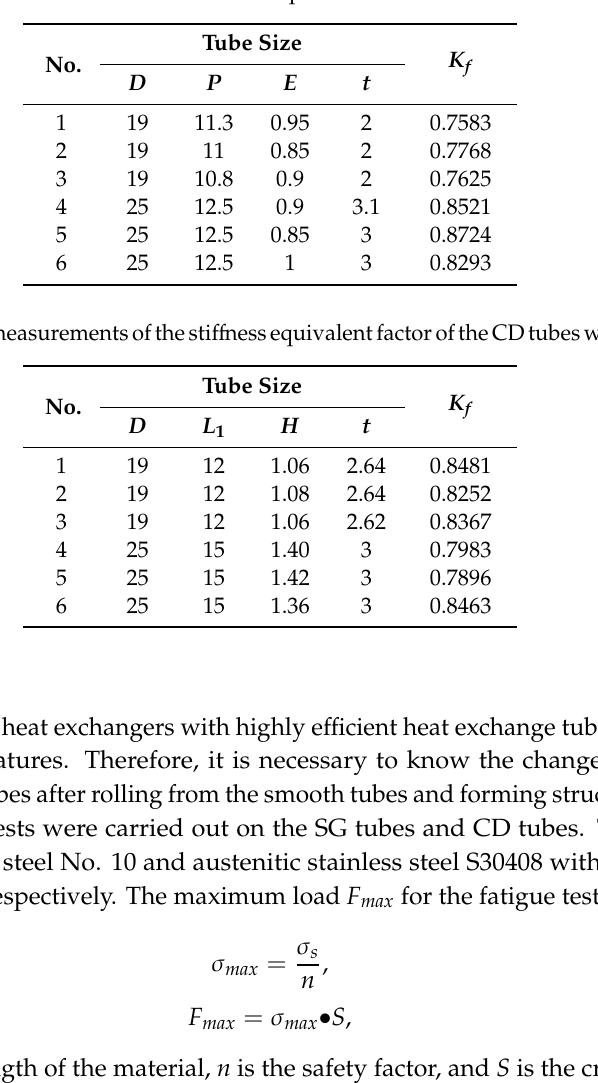
Table1. Experimentalmeasurementsofthesti ff nessequivalentfactoroftheSGtubeswithdi ff erentsizes.